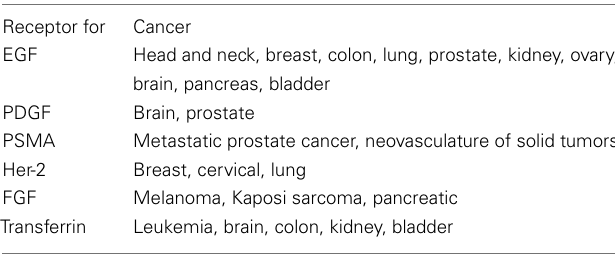
Table 1 | Examples of cancers with overexpressed growth factor